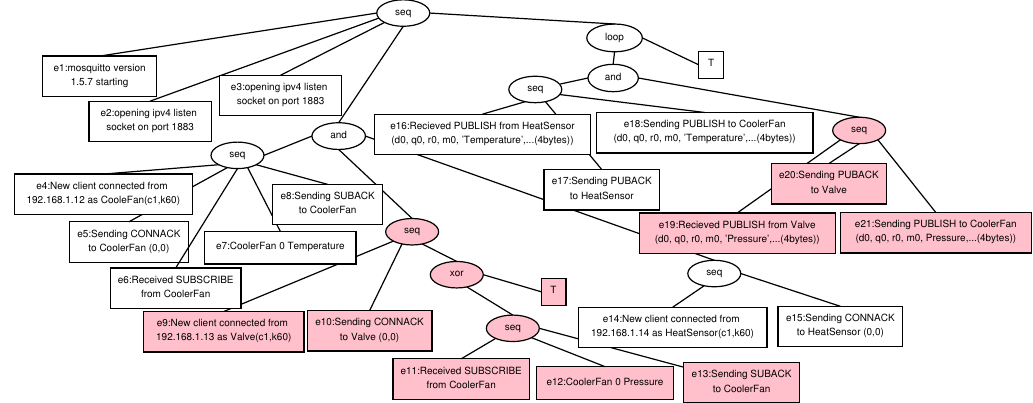
Figure 8. A process tree model L α representing the normal behavior. The nodes colored in red show events with fluctuations, such as dropped and delayed messages. The normal model tolerates missing nodes and perturbed